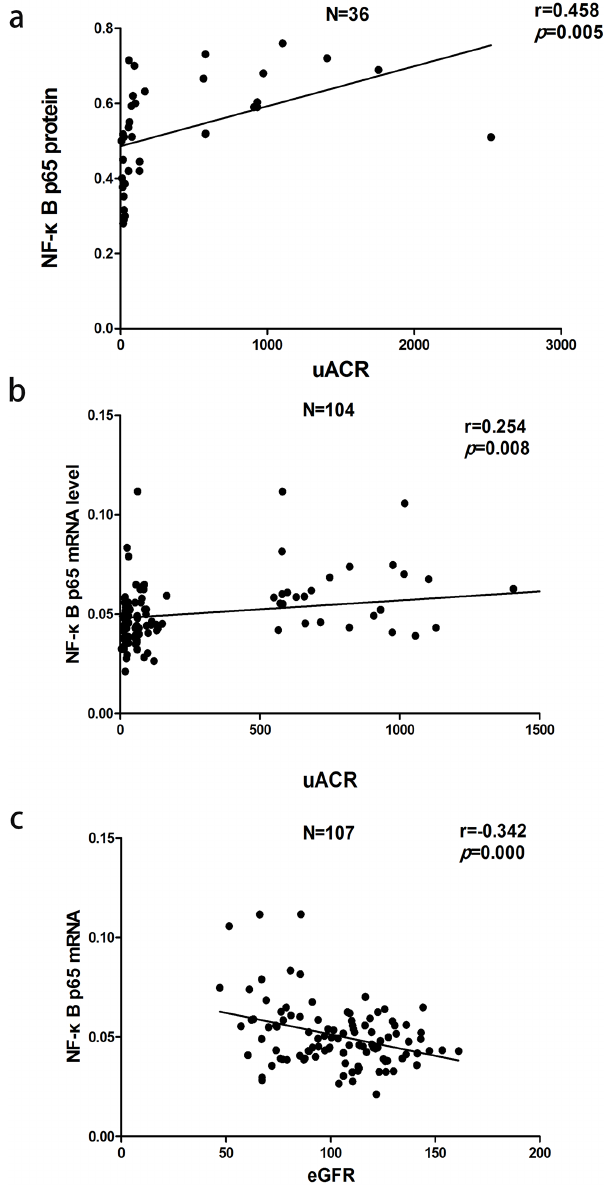
Figure 8. Correlation between peripheral blood mononuclear cell (a) nuclear NF- k B p65 protein and uACR (b) NF- k B p65 mRNA and uACR, or (c) NF- k B p65 mRNA and eGFR.